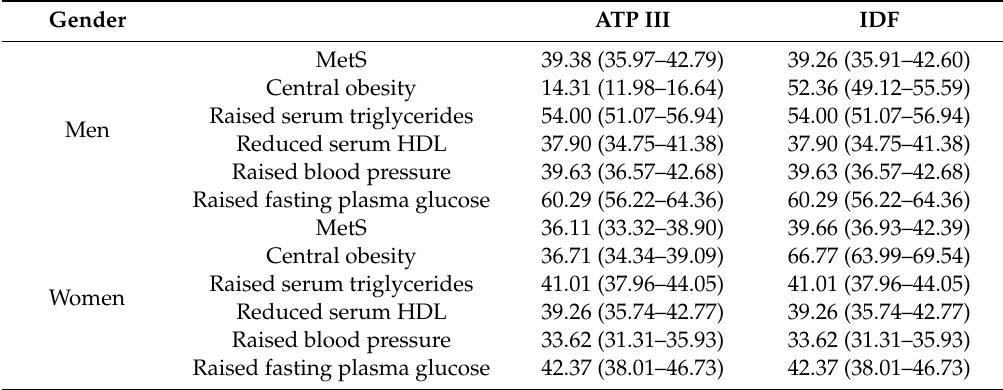
Table 2. Age-adjusted prevalence of MetS and five components in study subjects, by gender (N = 2121).